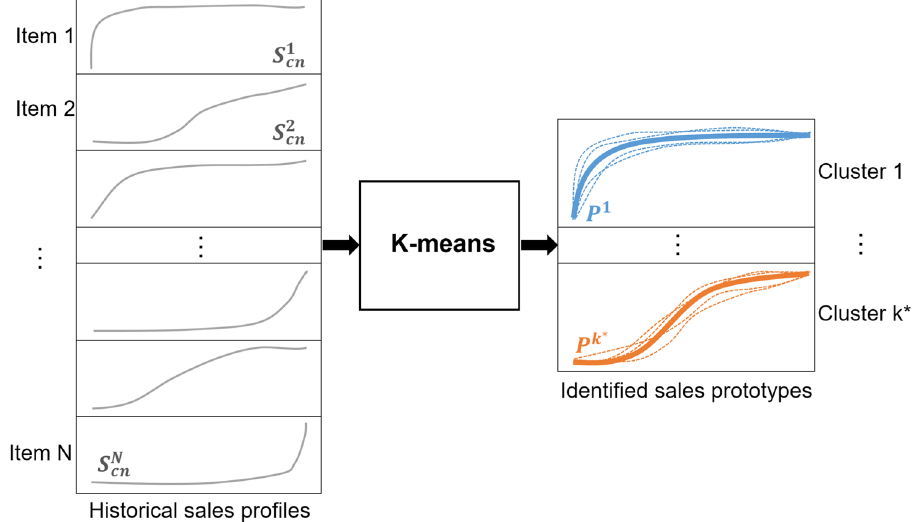
Fig. 4 K-means clustering of sales